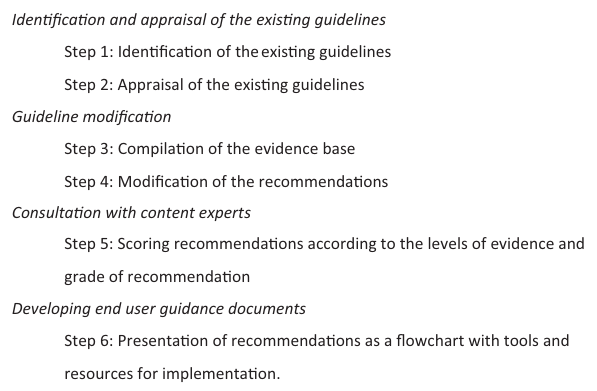
FIGURE 1: Stages of guideline